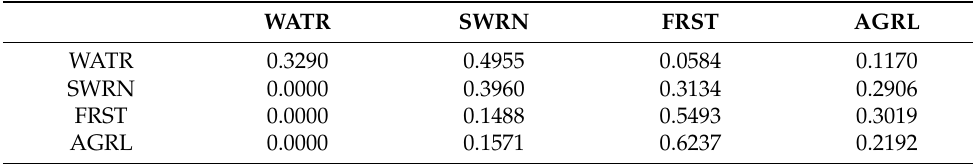
Table 4. Transition probabilities matrix for the year 2050.